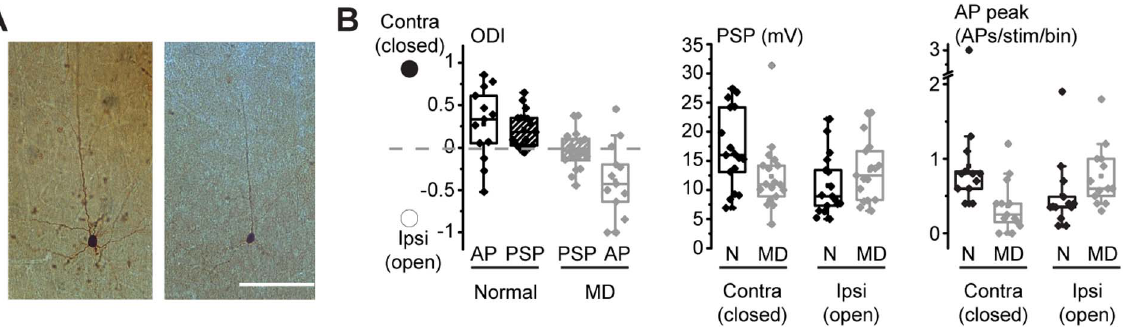
Figure 1. Sub- and supra-threshold effects of MD in 4RSNs of rat V1. A . Figure S1. Examples of anatomically recovered layer 4 star pyramids. 100 m m thick coronal sections were reacted for cytochrome C to reveal layer 4 and byocitin-filled cells were recovered with peroxidase-based histochemistry. Calibration bar: 100 m m. B . Left: the ocular preference shift –as assessed by the decrease of the ODI- caused by MD (P20–P30) was larger for AP responses (open boxes) compared to PSP responses (dashed boxes). Middle: at the level of PSP responses, depression of responsiveness to the deprived eye was larger (Mann-Whitney Rank Sum test, p , 0.05) compared to potentiation of open eye responses (Mann-Whitney rank Sum test, p=0.1). Right: at the level of AP responses, both depression of responses to the deprived eye and potentiation of open eye responses were significant (Mann-Whitney Rank Sum tests, p , 0.05). For a more detailed analysis of date presented in this figure see also[41]